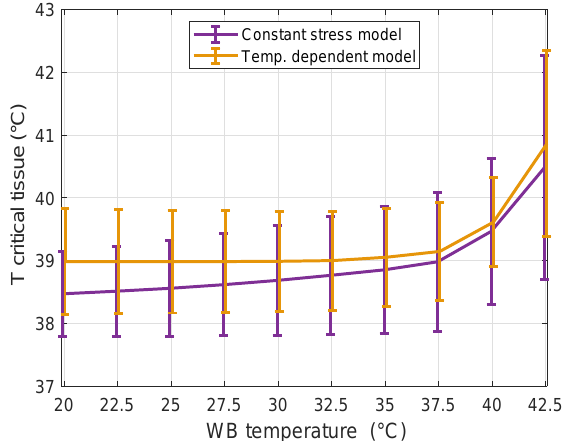
Figure 6. Average maximum temperature (±1 standard deviation) in critical tissues (spinal cord, brainstem and eyes) as a function of water bolus temperature and water bolus heat transfer coefficient h = 292 W m − 2 K − 1 .